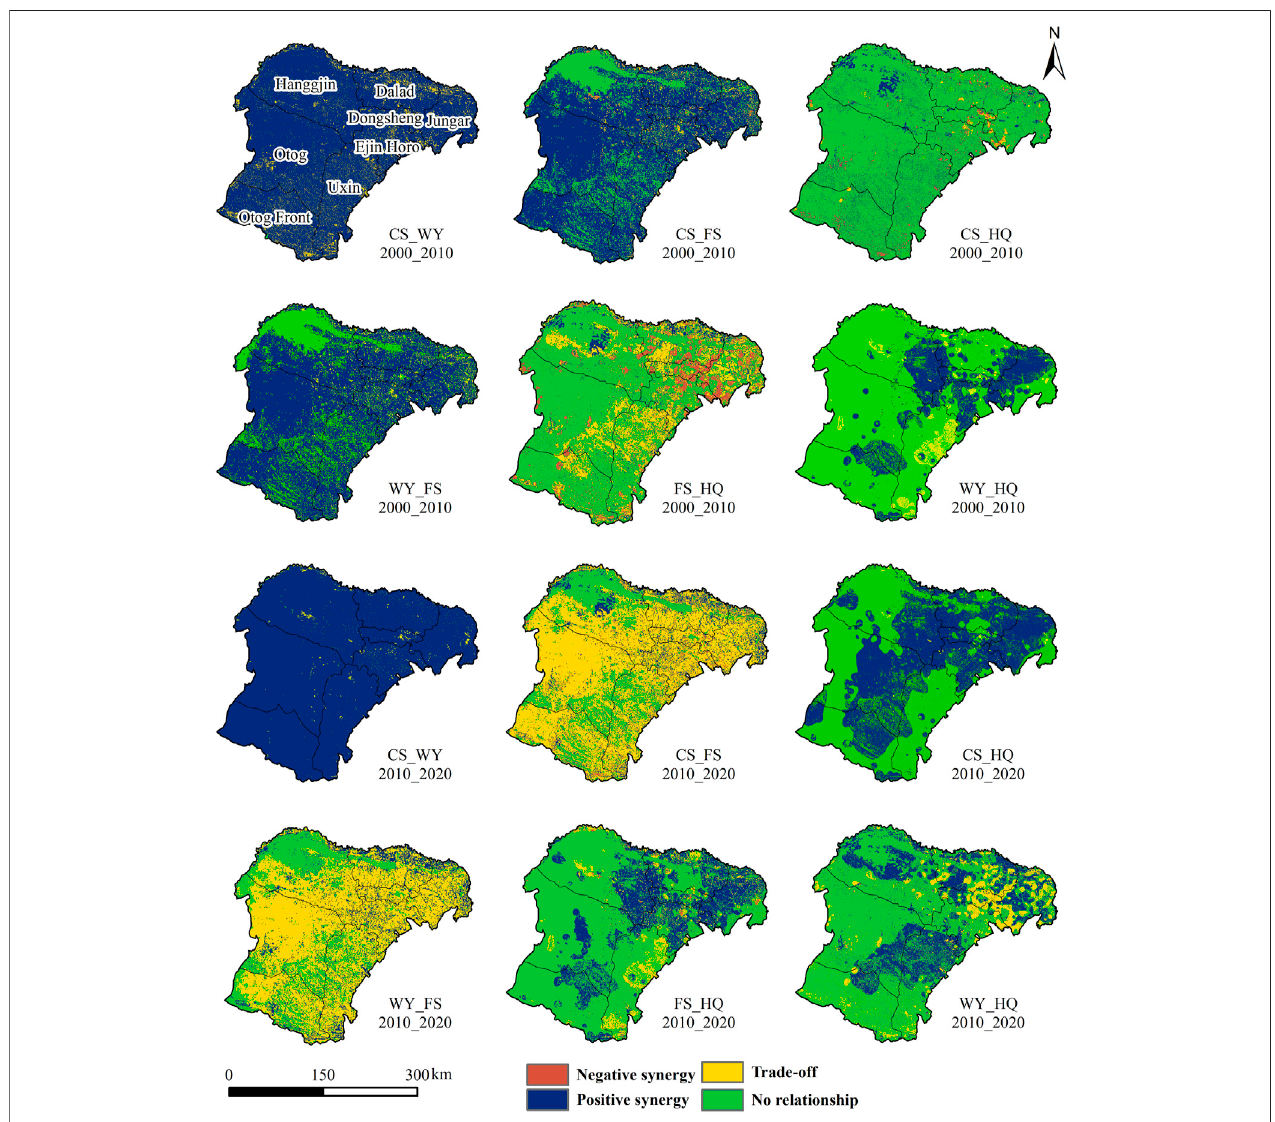
FIGURE 7 | Spatial distribution of ES trade-offs and synergies in Ordos from 2000 to 2020.